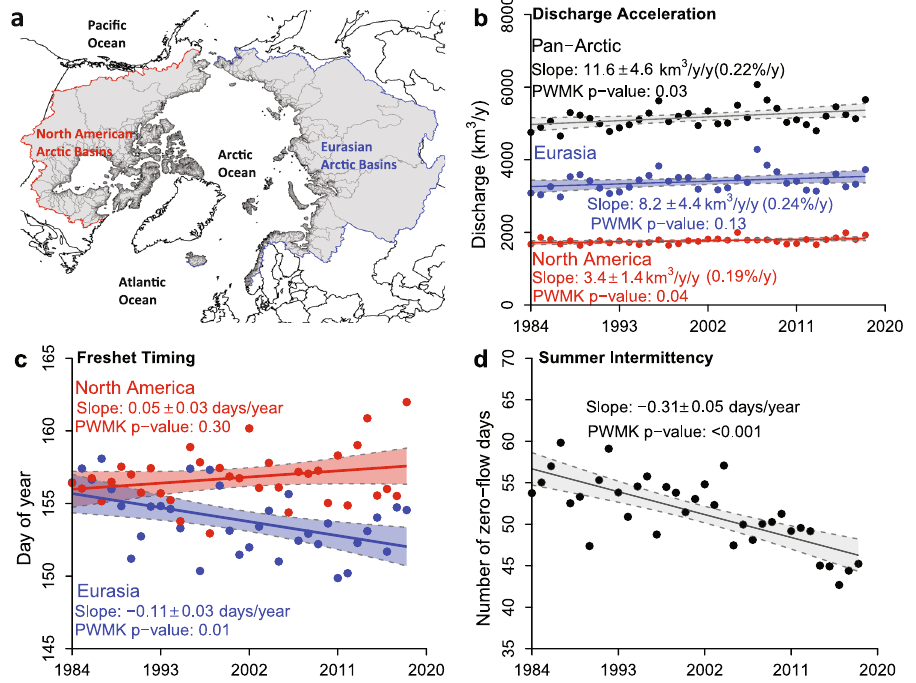
Fig. 1 Changes in total water export, freshet timing, and summer stream intermittency. a Map showing the pan-Arctic (gray shaded), North American (outlined in red), and Eurasian (outlined in blue) basins; b Water export from rivers shows increasing trends across the Pan-Arctic, Eurasia, and North America during 1984 – 2018; c The temporal centroid of spring freshet (TCSF) for North American and Eurasian rivers per year shows a signi fi cant advance of the TCSF for Eurasia. Data points represent the mean TCSF of all reaches in each region for 1984 – 2018; d The number of zero- fl ow days (ZFD) during the open-water period (Apr – Nov) has decreased signi fi cantly by 3.1 days/decade for streams prone to intermittency during 1984 – 2018. Each data point represents the annual average ZFD for all intermittent reaches across the pan-Arctic. The shade in b , c , and d indicates the 95% con fi dence interval. See Methods for the de fi nitions of total water export, TCSF, ZFD, and intermittent reaches. PWMK refers to the pre-whitening Mann – Kendall test for trend signi fi